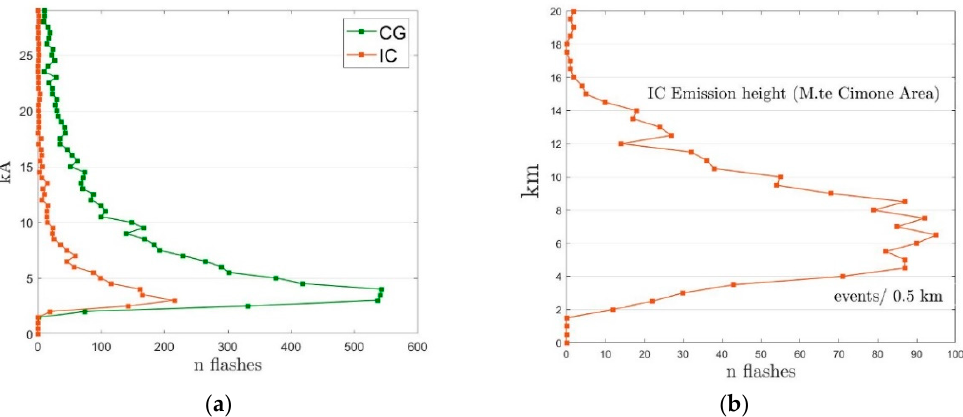
Figure 6. ( a ) LINET lightning amplitude distribution in the Mt. Cimone area divided into CG and IC data in steps of 0.5 kA; ( b ) LINET IC emission height (steps/0.5 km). Area considered: 5 km radius around the Mt. Cimone Observatory. Data range: 2012–2020.